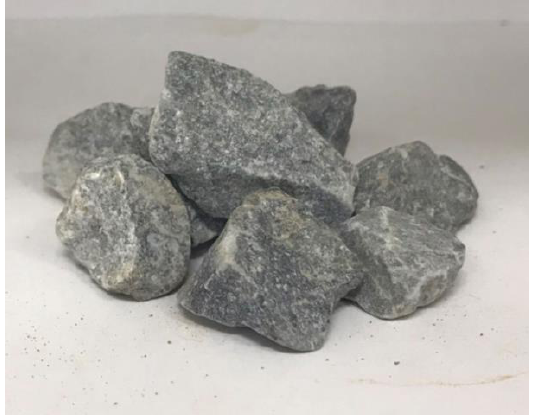
Figure 2. Natural aggregates.